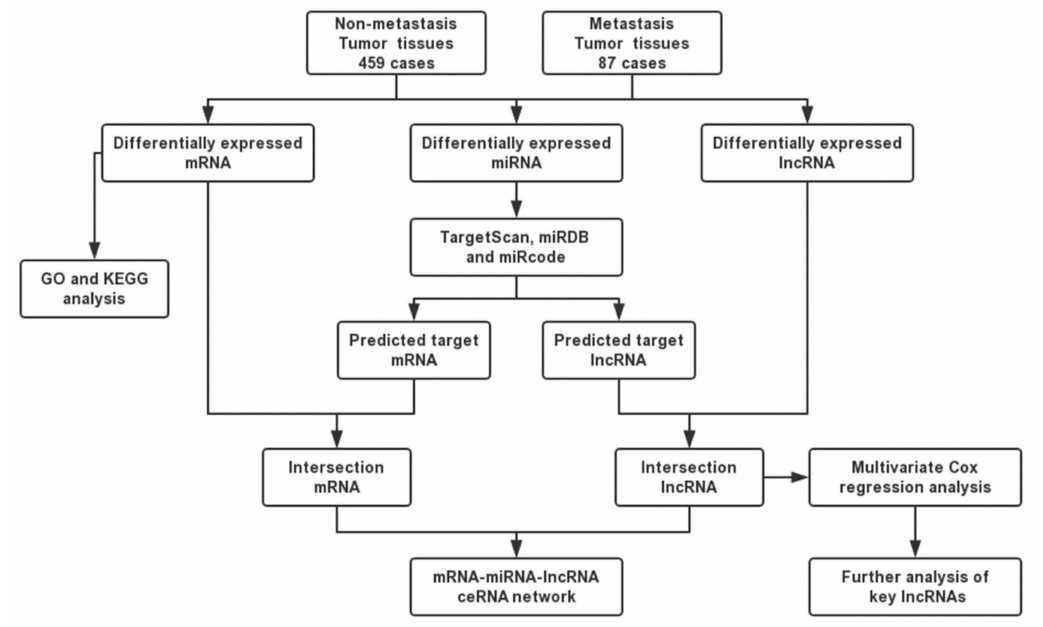
Figure 1. Flow chart of construction of competing endogenous RNA (ceRNA)